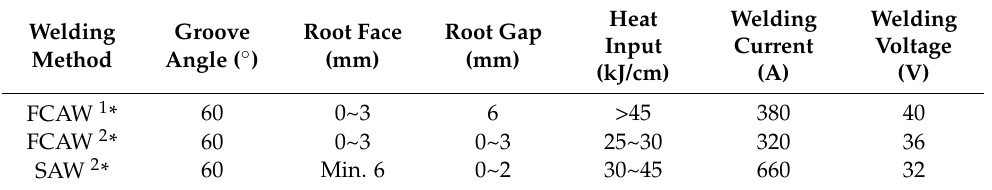
(3) welding voltage 32 V. Table 2 lists the main parameters used for the welding process. Table 2. Welding parameters used for welding process.